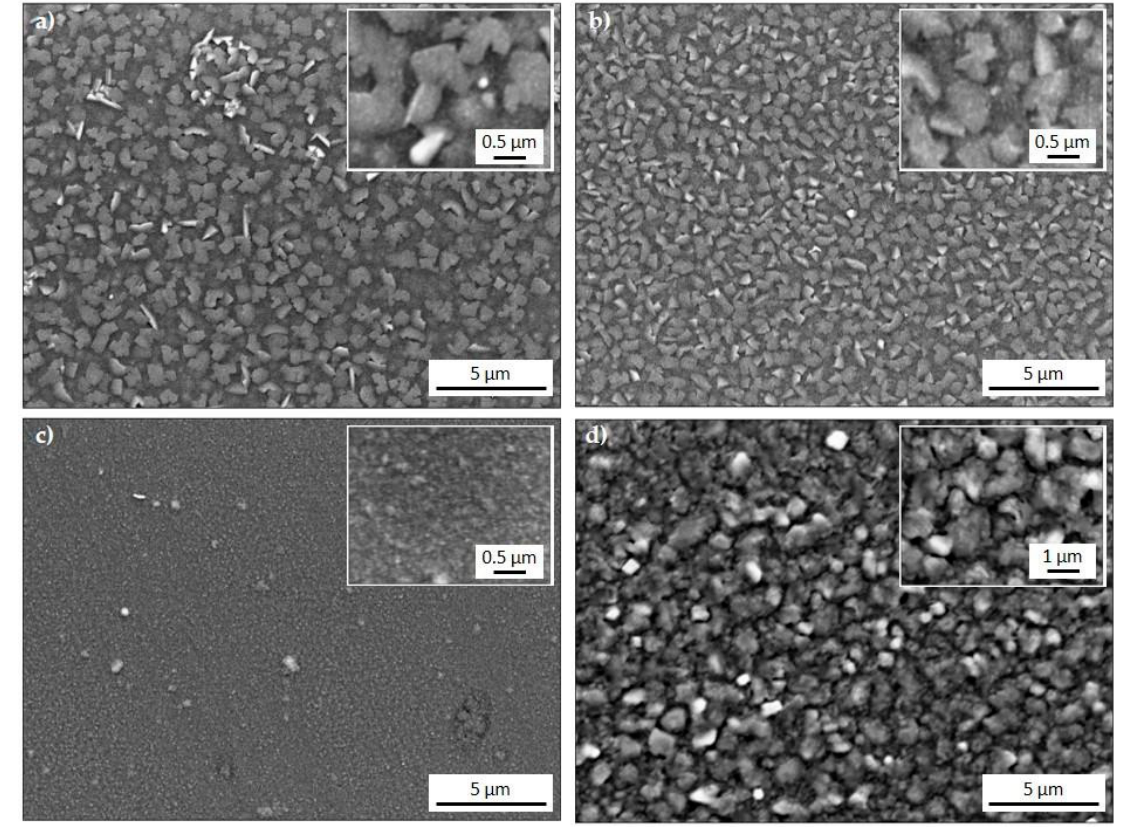
Figure 4. SEM images of the aged samples: ( a ) quartz glass; ( b ) ITO; ( c ) soda-lime glass; ( d ) gold. Insets display zoomed views of the same images.